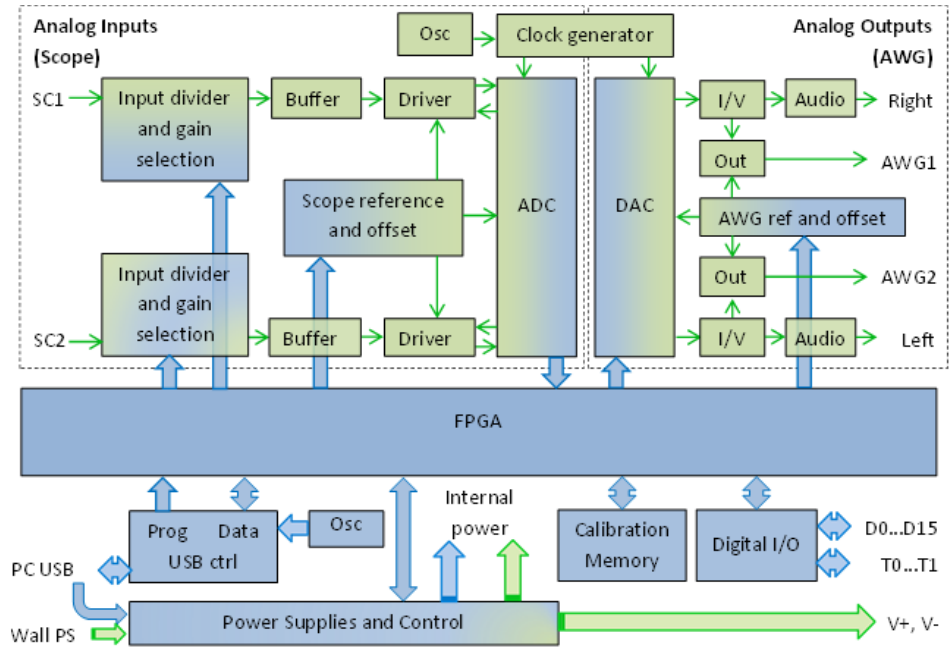
Figure 6. Analog Discovery 2 (AD2) block diagram adapted from its datasheet.